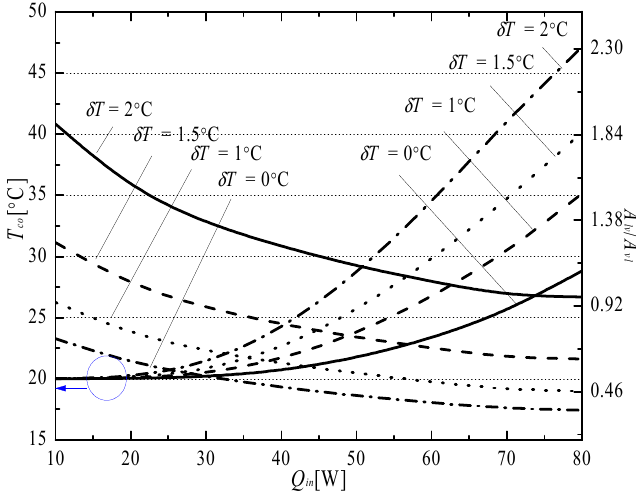
Figure 14. Variations in T co and A lv / A vl as functions of thermal load.